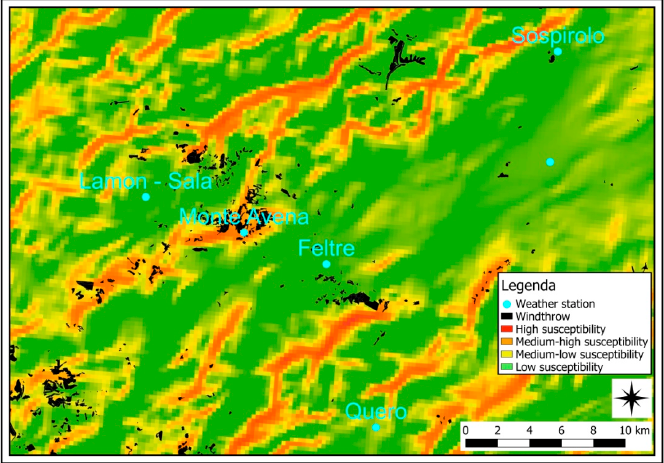
Figure 19. Wind damage susceptibility map.